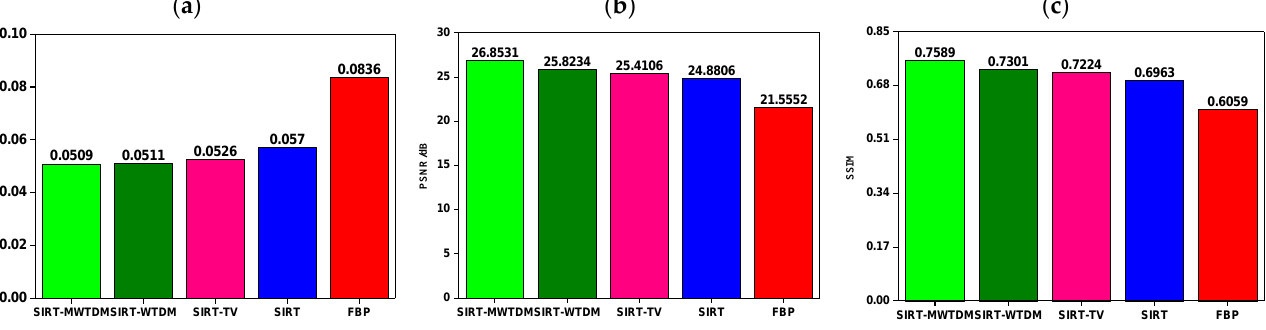
Figure 11. The histograms of evaluation index for reconstructed neutron images from 60 projections. ( a ) RMSE; ( b ) PSNR; ( c ) SSIM.